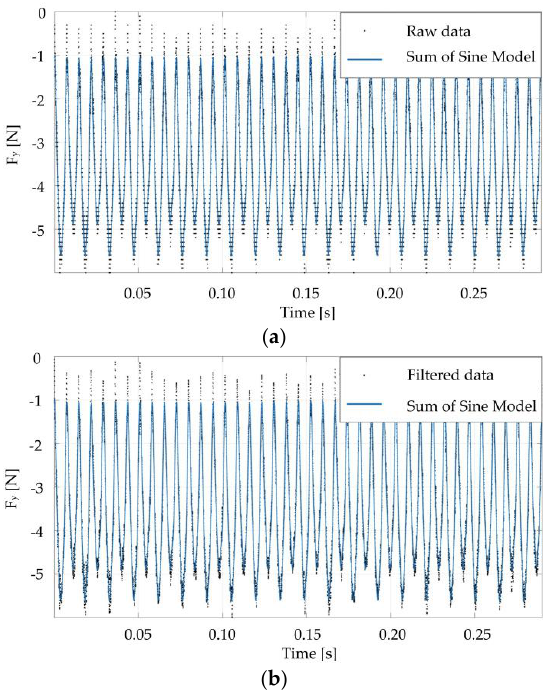
Figure 10. Sum of sine fitting function obtained from rough ( a ) and filtered ( b ) experimental cutting force components along the Y -axis (Test 90).